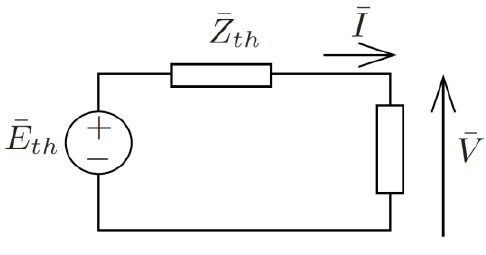
Figure 5. Circuit schematic of the Thevenin equivalent and load used to determine the VIP.